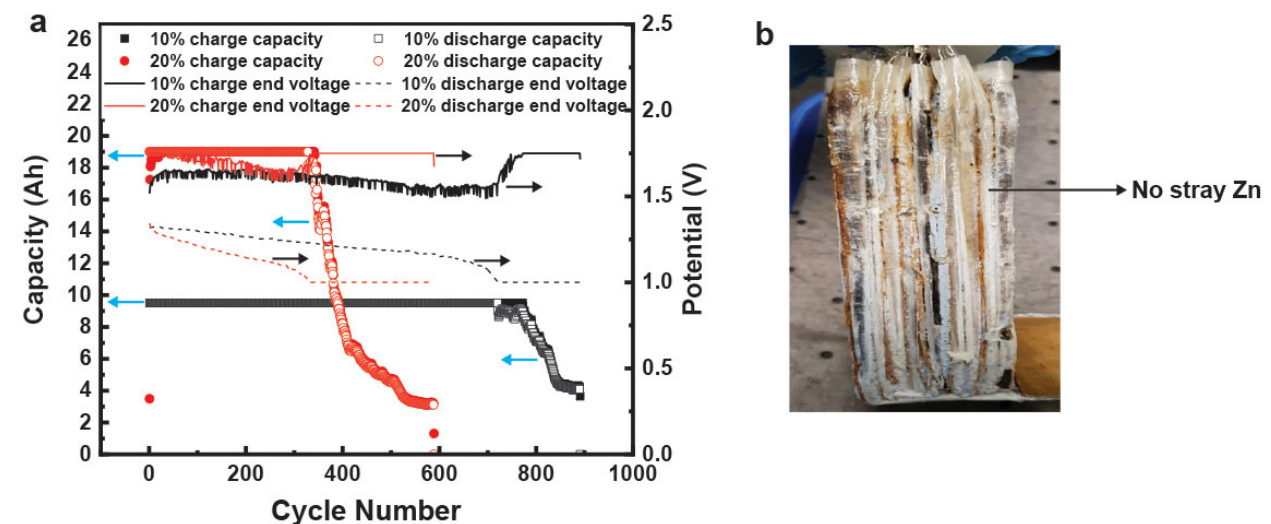
Figure 12. ( a ) Capacity retention and maximum and minimum voltage fade for a commercially made Zn–MnO 2 cell containing 36 wt.% hydrogel electrolyte nameplated at 19 Ah. ( b ) Photograph of a dissected commercially made Zn–MnO 2 cell containing 36 wt.% hydrogel electrolyte.